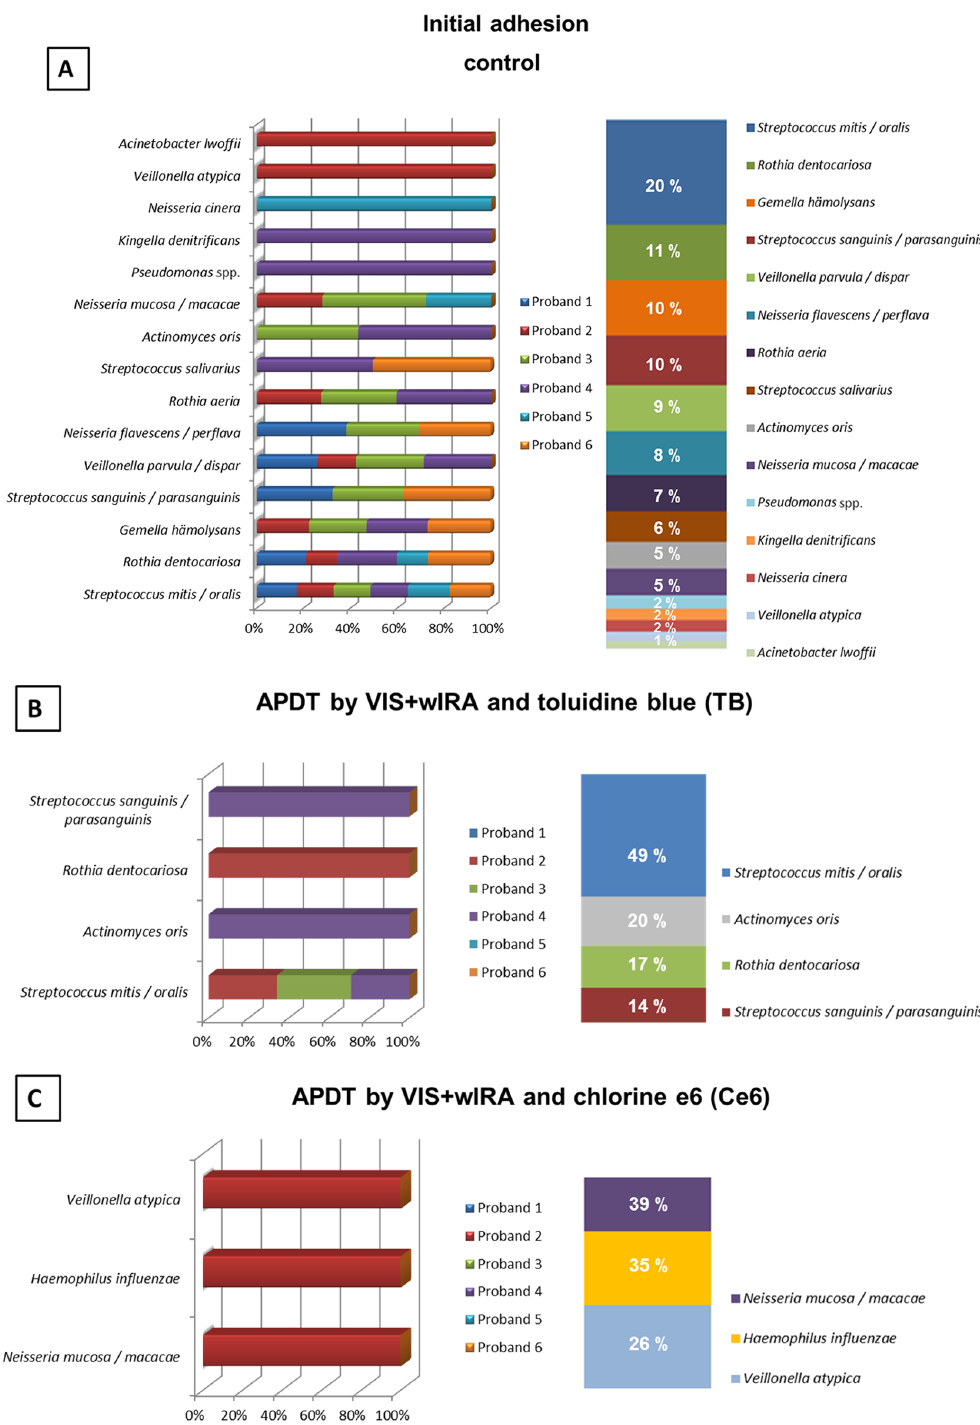
Fig 4. Relative distribution among the volunteers and total distribution (in percentages) of the initially adherent bacterial species from 6 individuals after application of antimicrobial photodynamic therapy (aPDT) using visible light (VIS) plus water-filtered infrared-A (wIRA). Graph A depicts the bacterial composition of the untreated negative controls. Graphs B and C show the bacterial composition after the ex vivo treatment with VIS + wIRA and the photosensitizers (100 μ g/ml) toluidine blue (TB) and chlorine e6 (Ce6) on oral microorganisms after a 2-hour (h) cultivation in situ . Consistent color coding was used for the study participants and detected bacteria as indicated by the schemes at the left and right of panels A, B and C respectively.